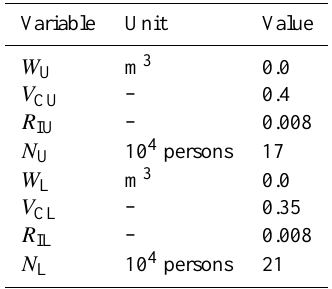
Table 2. Initial values of system state